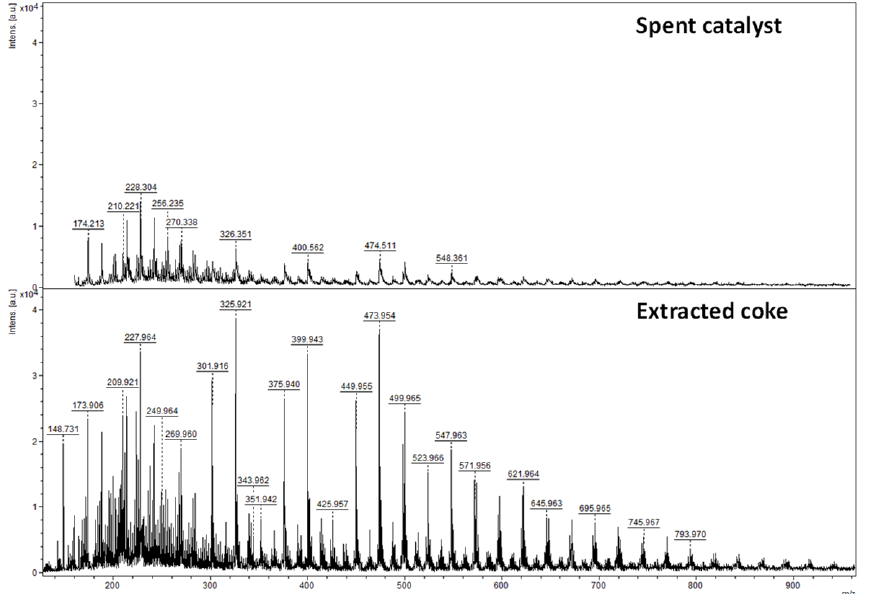
Figure 6. Comparison of LDI-TOF/MS spectrum between the spent catalyst and the extracted coke by HF.